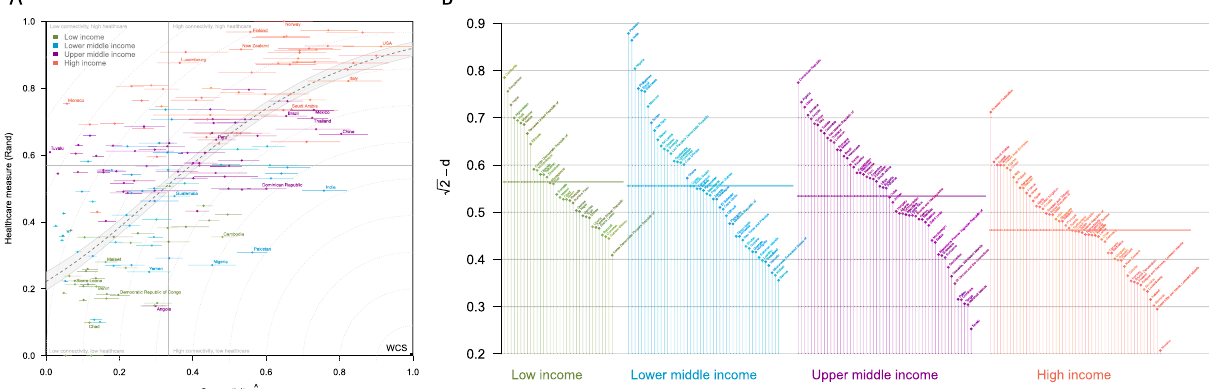
ˆ φ Figure 2. ( A ) Distribution of countries according to their average connectivity ( ) and healthcare development index (Rand index). Each country is colour-coded according to their World Bank income group. The dashed line is a fitted spline with 95% confidence intervals denoted by the grey area. The annotated WCS point represents the ‘Worst Case Scenario’ (greatest connectivity but worst healthcare index), and grey dotted arcs indicate equivalent distance from the WCS. ( B ) Proximity measurement to the Worst Case Scenario (WCS) for all countries, derived using the Rand index. Countries are grouped by World Bank income category and ranked within group. Countries close to the WCS score high, while countries further away from the WCS score low. Group mean averages are denoted by coloured horizontal